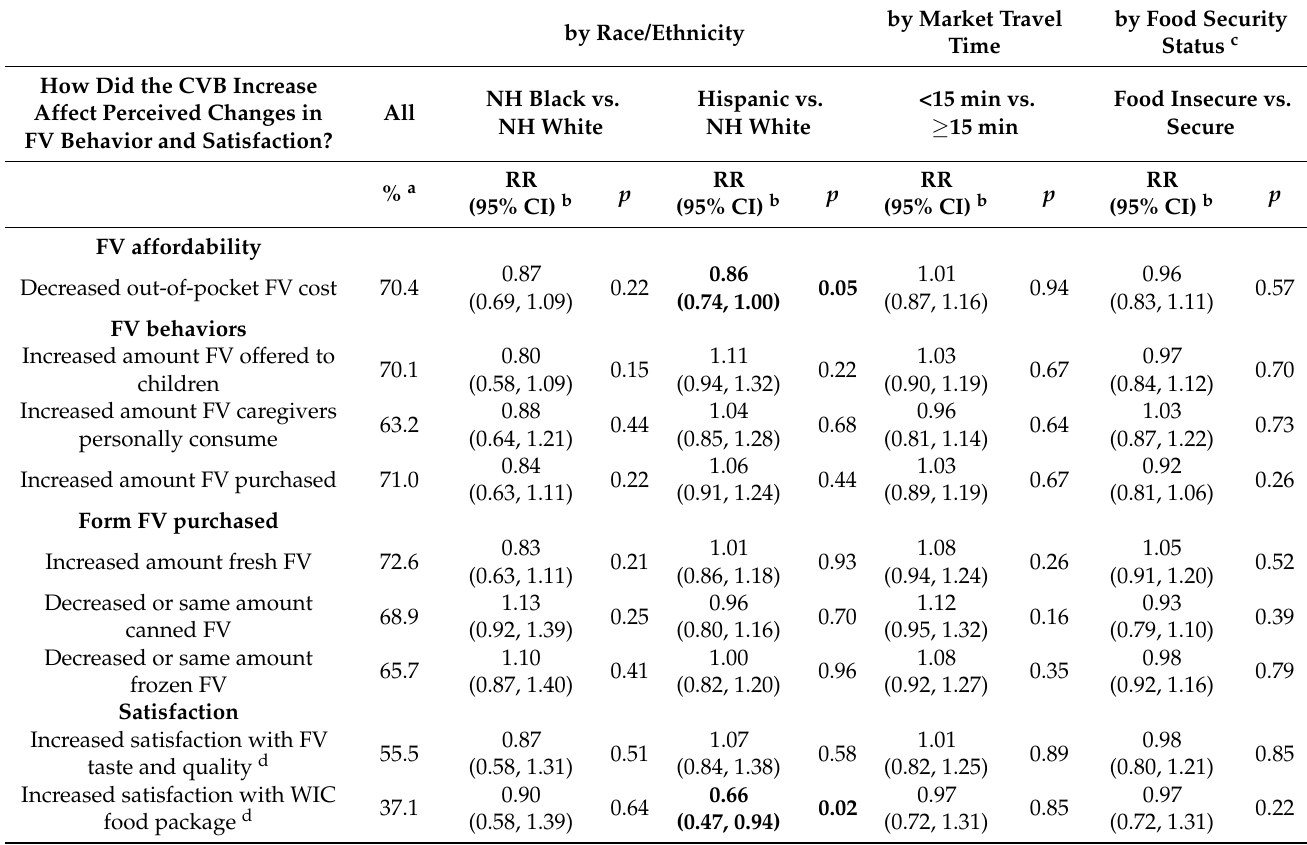
Table 3. Frequency of Perceived Improved FV Behaviors and Satisfaction Outcomes, and Estimated Adjusted Probability of Reporting Improved Outcomes, by Race/Ethnicity, Average Market Travel Time, and Food Security Status. by Market Travel by Food Security by Race/Ethnicity Time Status